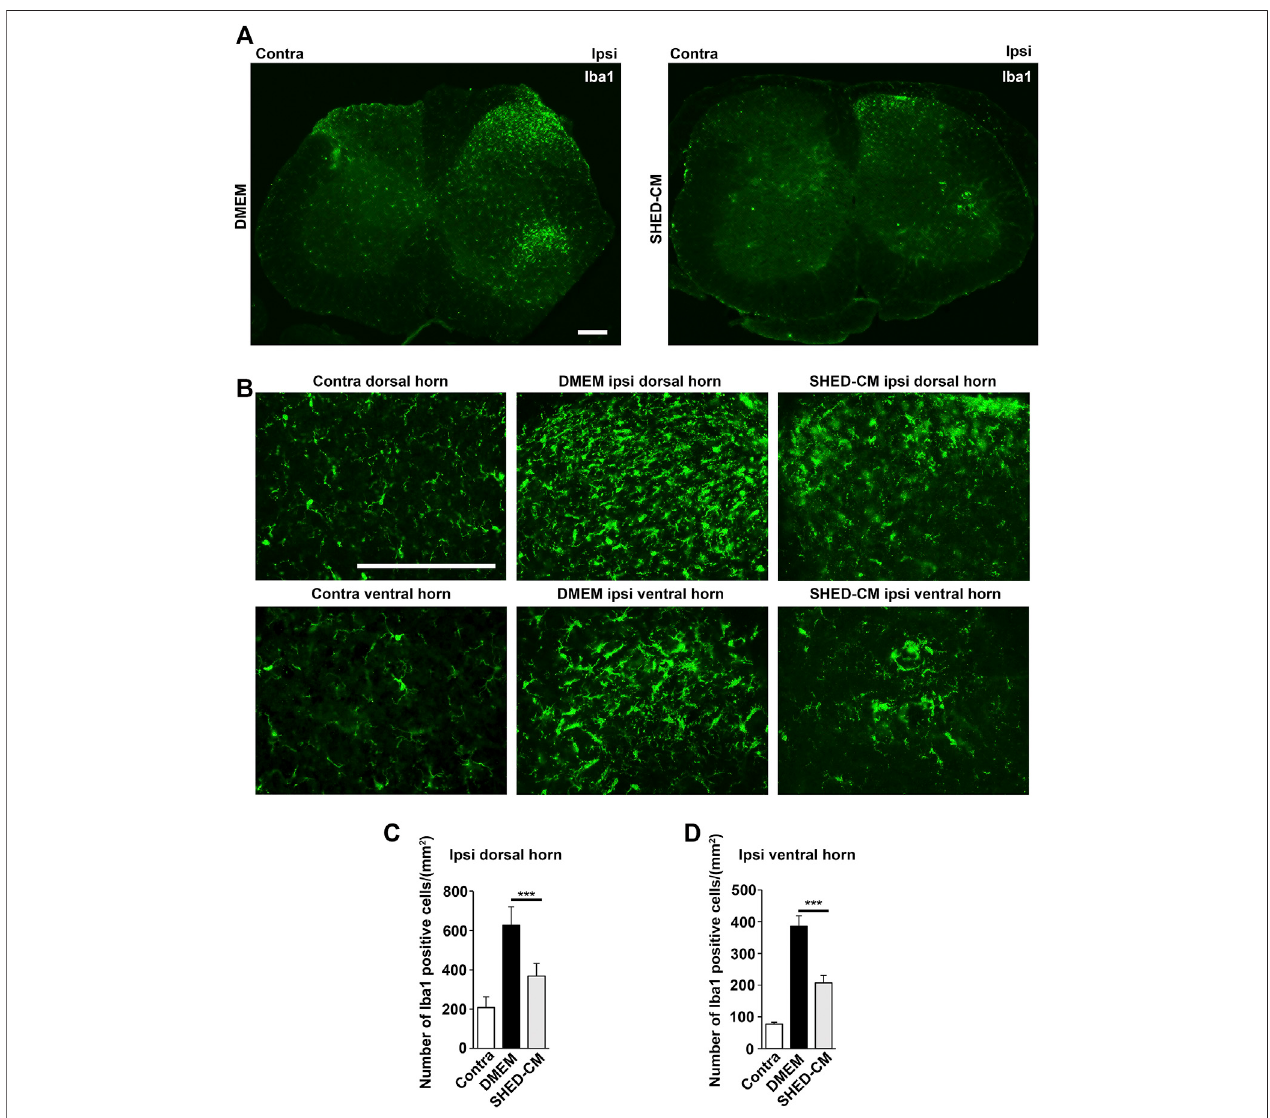
FIGURE4| SHED-CMtreatmentsuppressestheactivationofmicroglia. (A,B) Representativeimagesofimmuno fl uorescentstainingofIba1inthecontralateraland ipsilateral horn of L3/4 SP 7 days after PSL in the early phase model. (C,D) Iba1 + cell numbers in the (C) dorsal and (D) ventral horn of L3/4 SP. Scale bar: 200 μ m in (A,B) . Student ’ s t -test ( n = 7 – 10, per group). Data represent the mean ± SD. *** p < 0.001.